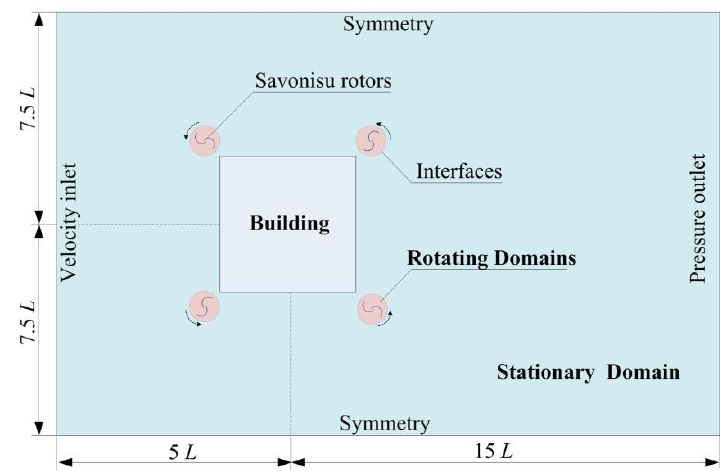
Figure 3. Computational domains and boundary conditions (the display is not scaled).